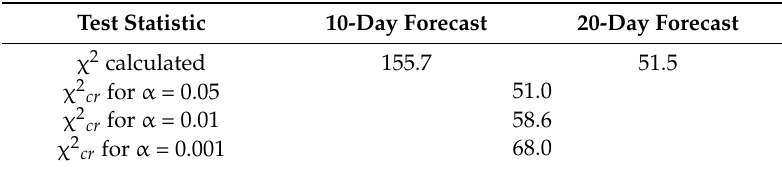
Table 4. Chi-squared ( χ 2 ) values for SPI forecasts in seven categories ( n = 1330; df = 36). Test Statistic 10-Day Forecast 20-Day Forecast χ 2 calculated 155.7